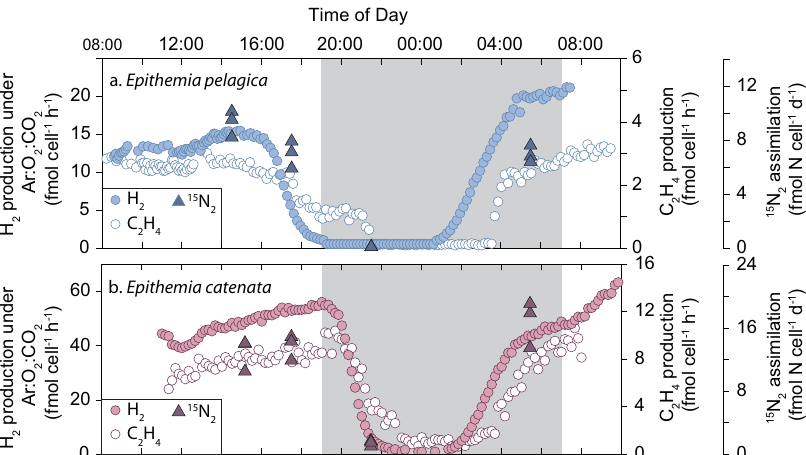
Fig. 4 Daily patterns of N 2 fi xation for Epithemia . a Dihydrogen (H 2 ) production, ethylene (C 2 H 4 ) production from acetylene (C 2 H 2 ), and 15 N 2 assimilation for E. pelagica UHM3200. b H 2 production, C 2 H 4 production from C 2 H 2 , and 15 N 2 assimilation for E. catenata UHM3210. Sampling resolution was 10 min for H 2 and C 2 H 4 production and 2 h for the 15 N 2 assimilation with the values represented by average ± standard deviation ( n = 3). The 15 N 2 assimilation beginning at 20:30 had rates of 0.1 fmol N cell − 1 d − 1 for E. pelagica . The night period is represented by gray shading in both plots. Source data are provided in the Source Data fi